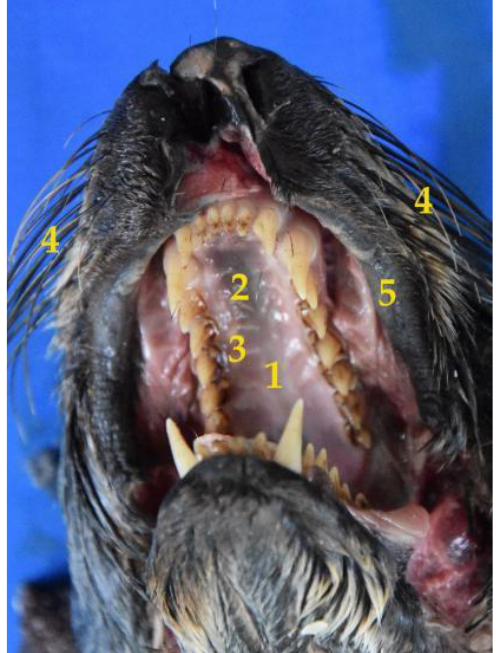
Figure 1. Image of the snout and the oral cavity of the Arctocephalus australis. ( 1 ) Hard palate; ( 2 ) median raphe; ( 3 ) curved ridges; ( 4 ) vibrissae; ( 5 ) upper lip.